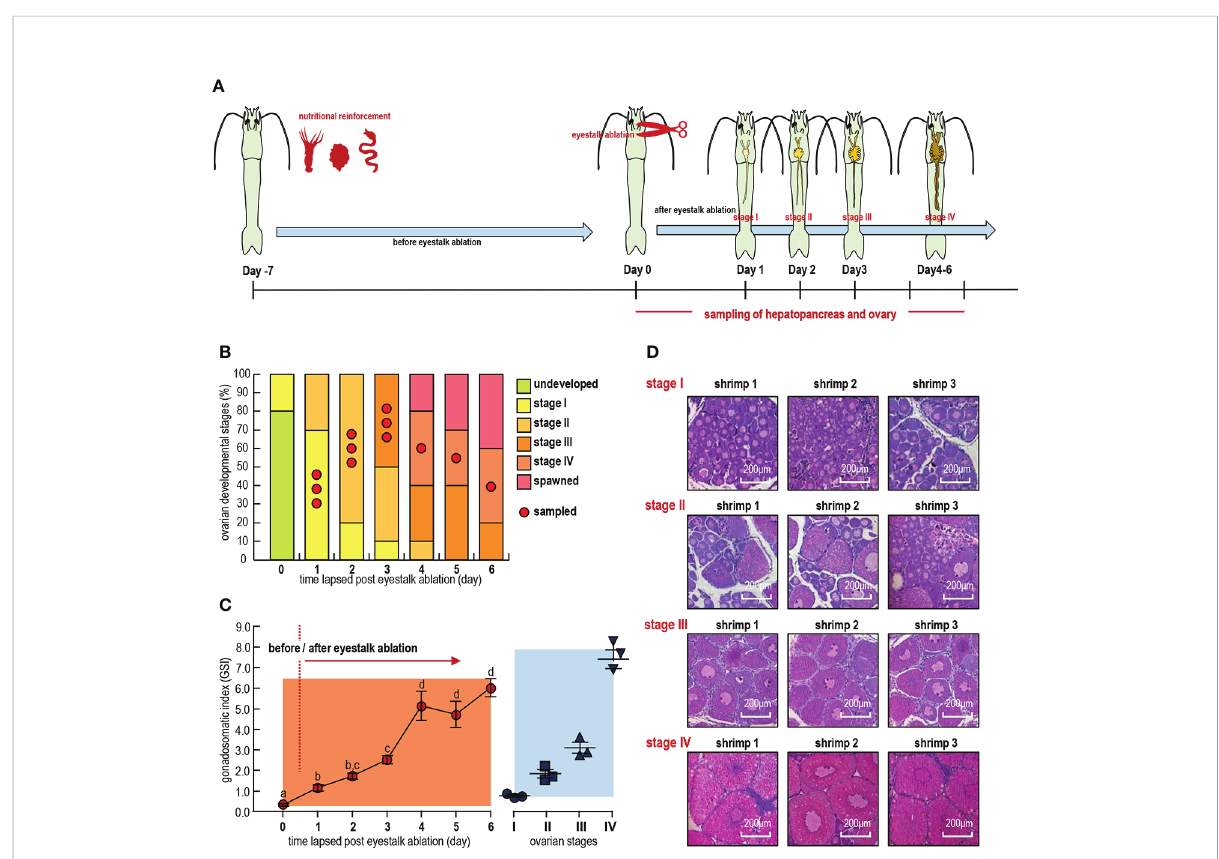
FIGURE 1 (A) Representative ovaries at different time points. (B) Distribution of samples over ovarian developmental stages. (C) Changes in gonadosomatic index (GSI) with days and ovarian developmental stages after eyestalk removal. Error bars represent standard derivations. Different letters indicate signi fi cant differences between time points of the same feed group (n = 3, mean ± sem, P < 0.05, ANOVA Duncan test). (D) HE staining of the ovaries and liver and pancreas. Stage: Four periods of ovarian